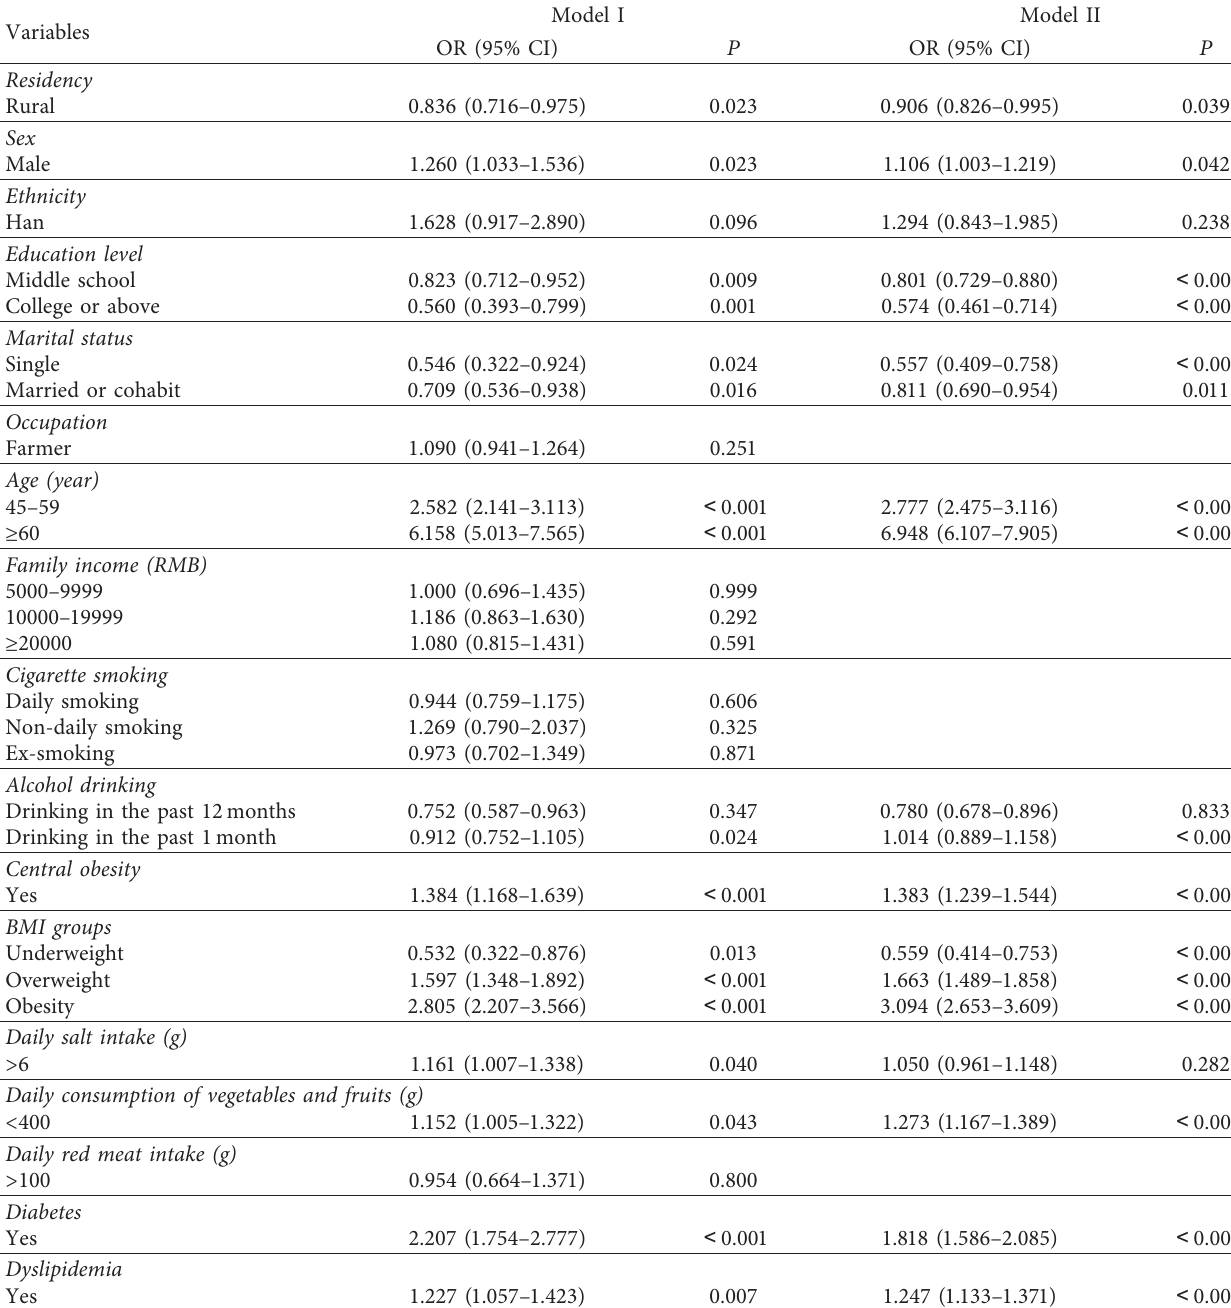
Table 3: Logistic regression analysis on risk factors of hypertension among adults from northwest